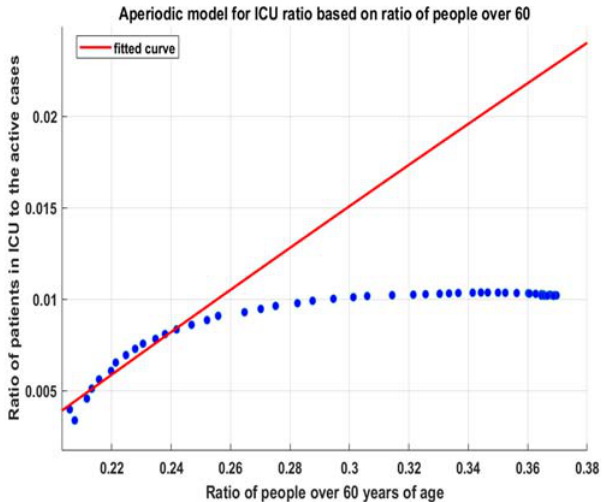
Figure 10. Deviation from a model for ICU in the period of 4 to 21 September 2021.